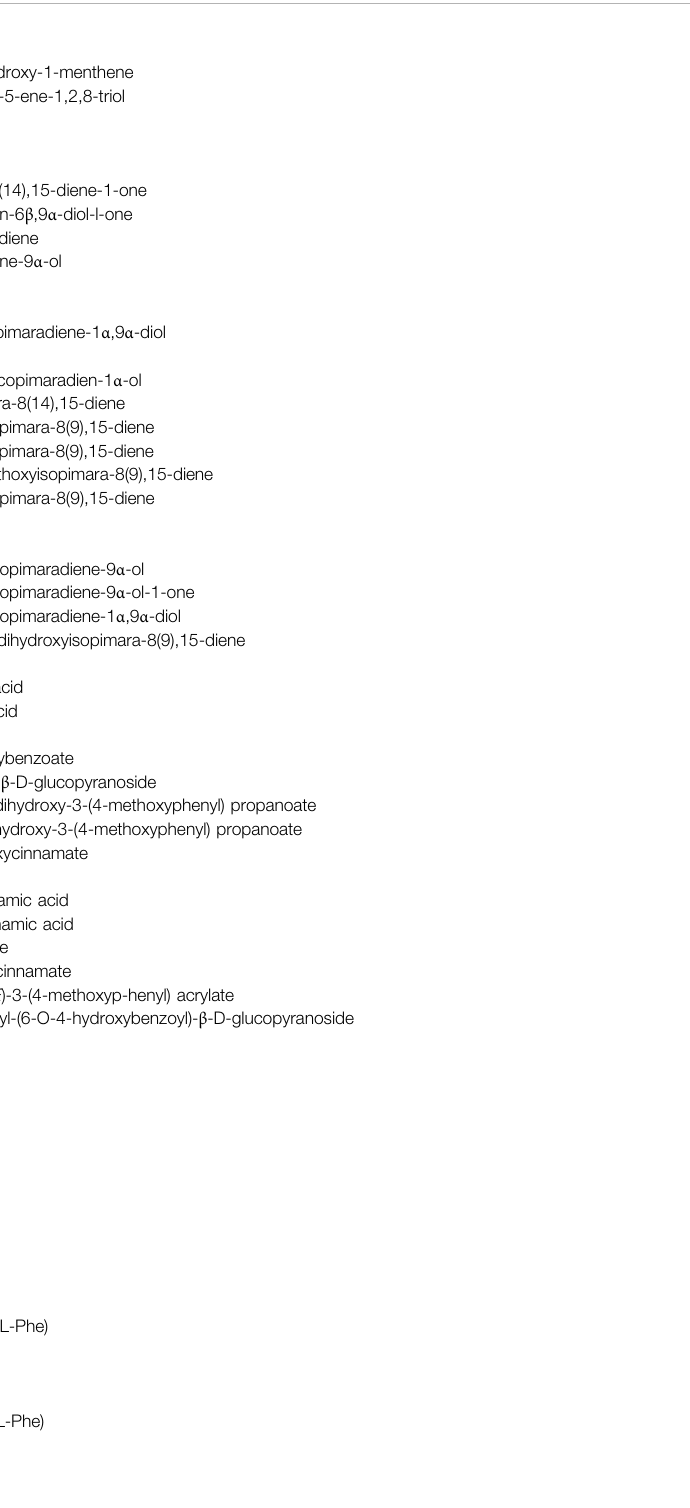
TABLE 3 | Chemical constituents isolated from K. galanga .